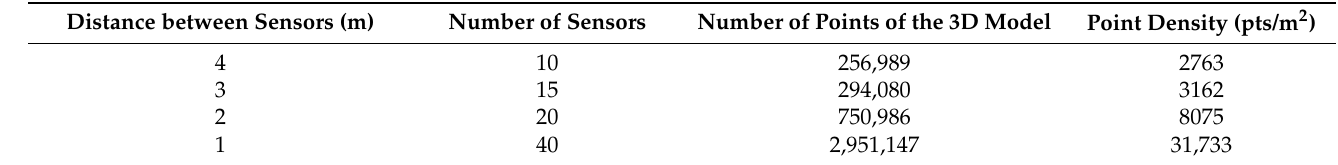
Table 3. The number of points obtained for the 3D model and point density according to both the distance between sensors and the number of sensors used. This test was carried out at a distance of 12 m from the investigated